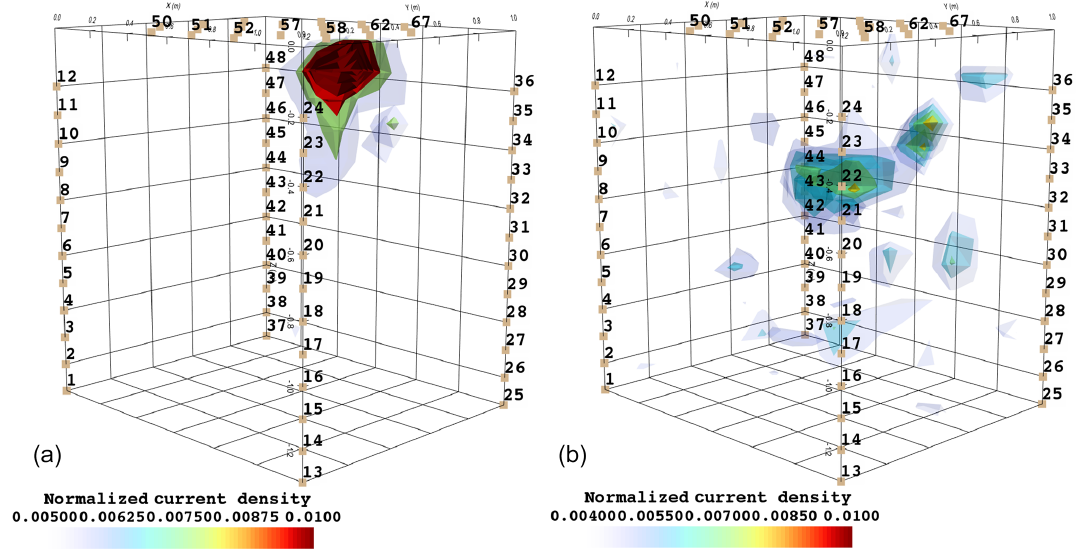
Figure 7. Current source density after minimization of the objective function F 2 as defined in Eq. (3). The results are relevant to the background time T 0 for plant B, for the soil current injection (a) and the stem current injection (b) .